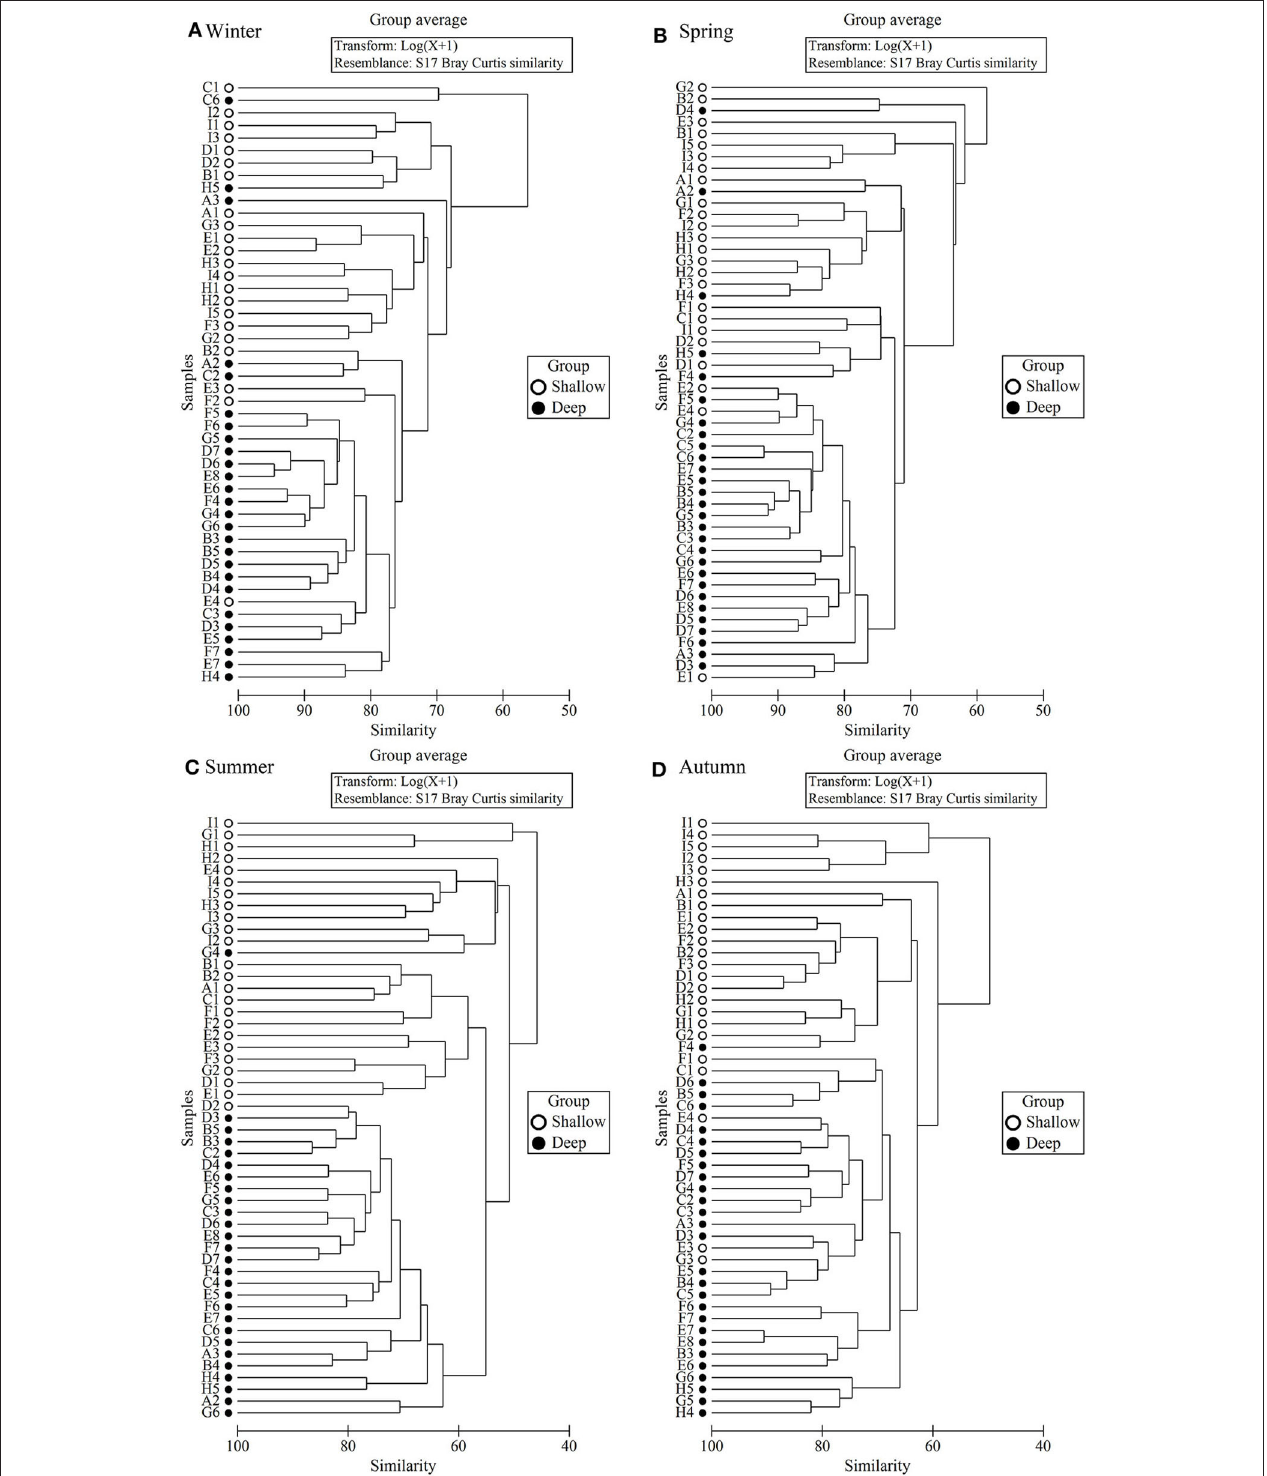
FIGURE 5 | Dendrogram of station similarity based on cluster analysis of zooplankton abundance. (A) Winter, (B) Spring, (C) Summer, and (D) Autumn.